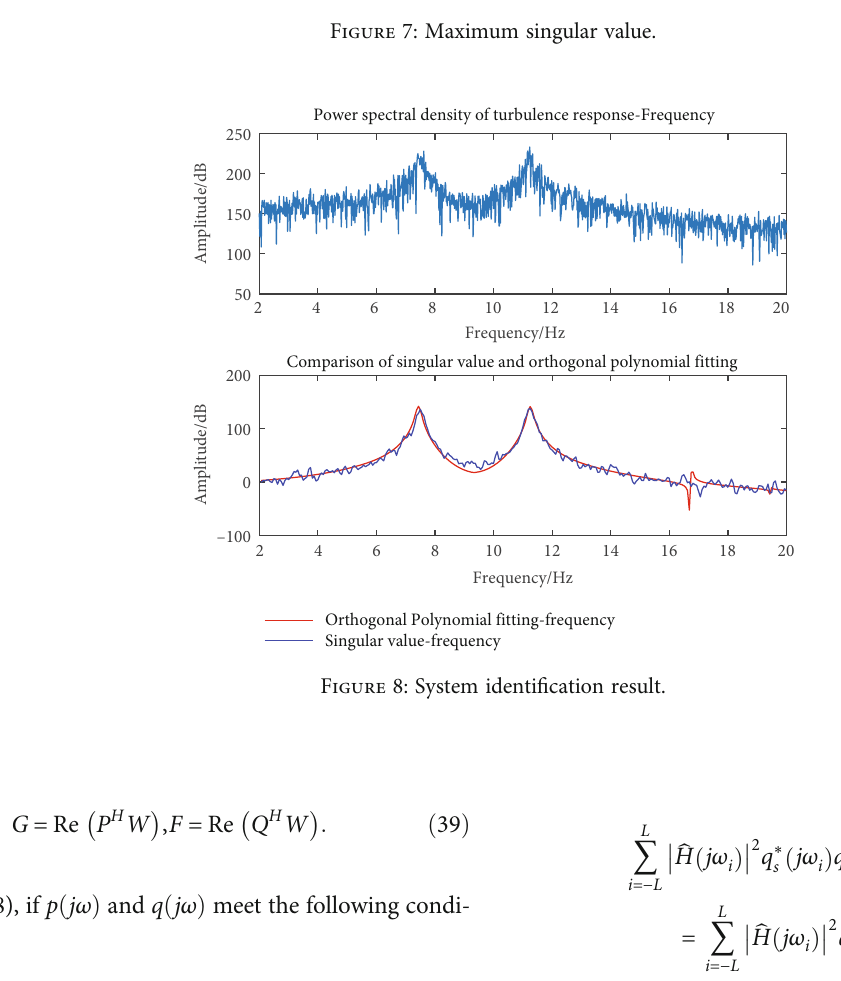
Figure 7: Maximum singular